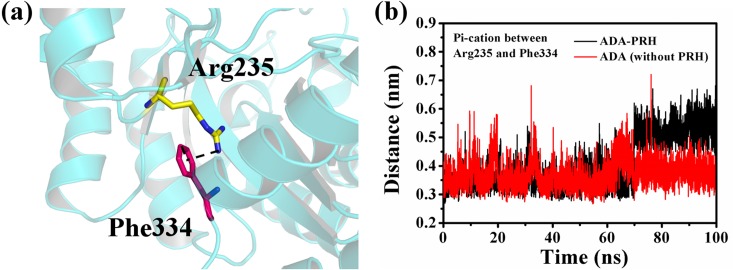
Cation–pi interaction between Arg235 and Phe334.(a) Arg235 is depicted in a yellow stick; and Phe334 is shown in a magenta stick. (b) The distance between the NH1 atom of Arg235 and the center of the benzene group of Phe334 in the 100 ns simulations.